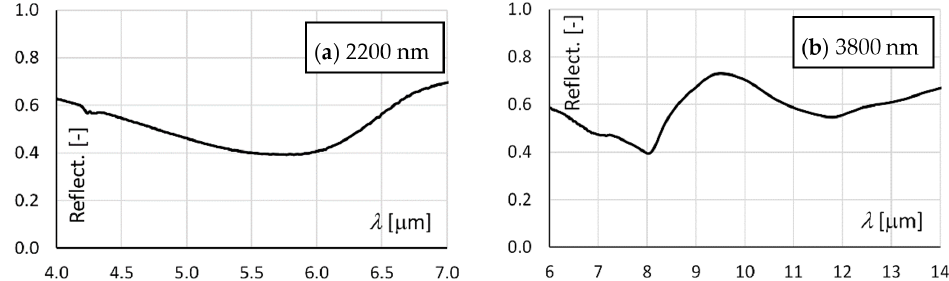
Figure 8. Measured reflectance of longer dipole array structures: ( a ) 2200 nm and ( b ) 3800 nm